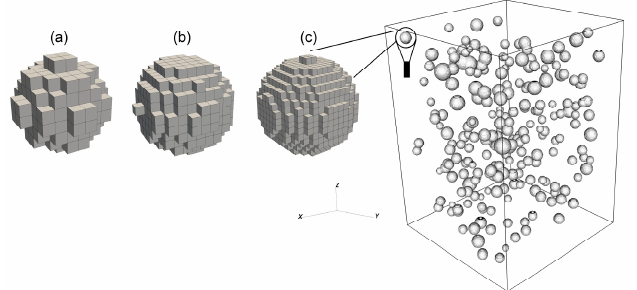
Figure 5. Description of a phase boundary using different meshes: ( a ) coarse (159 × 114 × 114 elements), ( b ) medium (255 × 183 × 183 elements), ( c ) fine (351 × 253 × 253 elements).